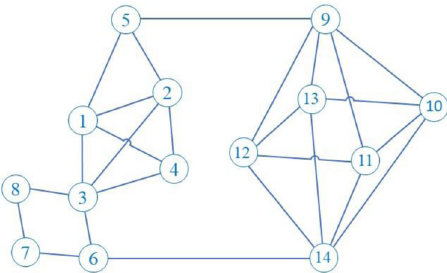
Fig. 1 A sample network. This network has 14 nodes, 26 edges, 13 triangles, and 1 tetrahedron, where the numbers are node indexes (see ref. 5 ).